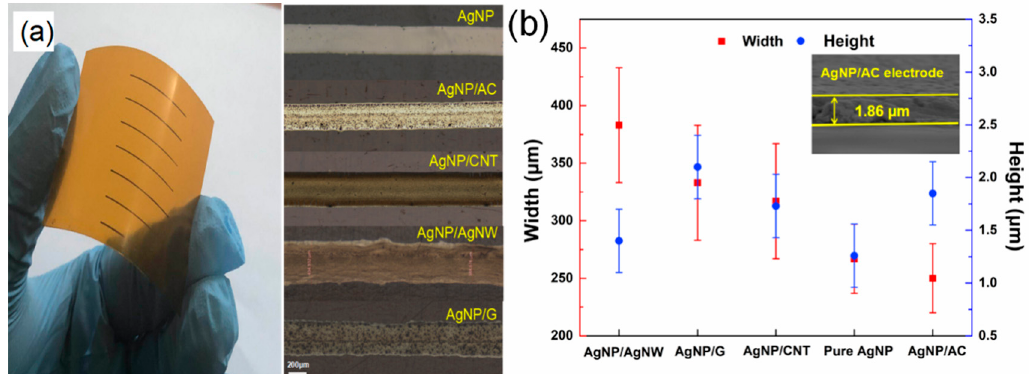
Figure 2. ( a ) Photograph and surface morphology of printed composite electrodes; and ( b ) thickness and line width of printed composite electrodes.